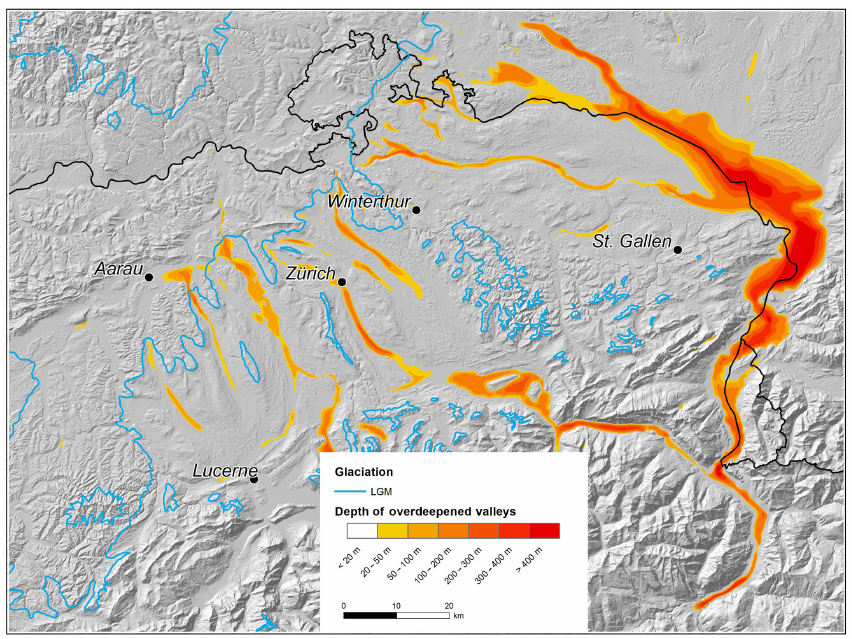
Figure 2. Depth of overdeepened valleys in the Rhine glacier basin (Pietsch and Jordan, 2014). Outlines of maximum glacial extent at the LGM (Bini et al., 2009) are shown in blue. Table 1. Model parameter